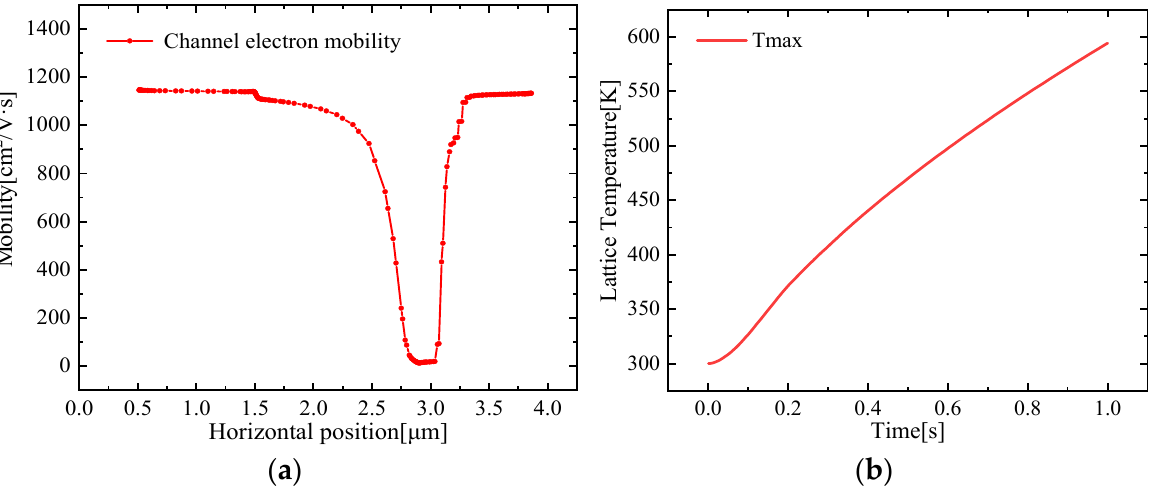
Figure 9. ( a ) Variation of electron mobility in the horizontal direction of the channel layer; ( b ) Tmax curve with self-heating effect over time.